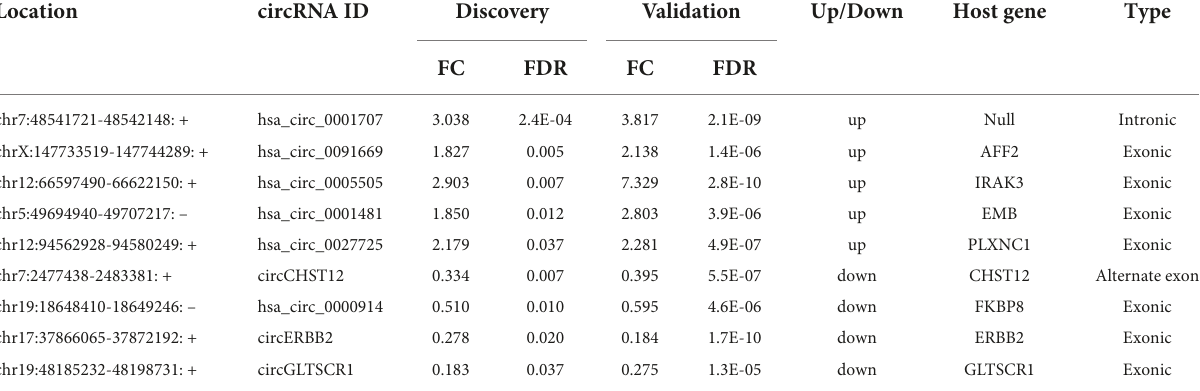
TABLE 2 The consistently altered circRNAs in intracerebral hemorrhage (ICH) patients compared with controls. Location circRNA ID Discovery Validation Up/Down Host gene